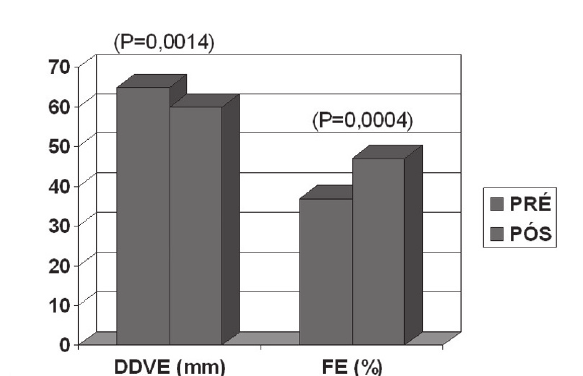
Fig. 2 - Comportamento do diâmetro diastólico ventricular esquerdo (DDVE) e da fração de ejeção ventricular esquerda (FE), em pacientes com insuficiência cardíaca avançada submetidos a implante de ressincronizador